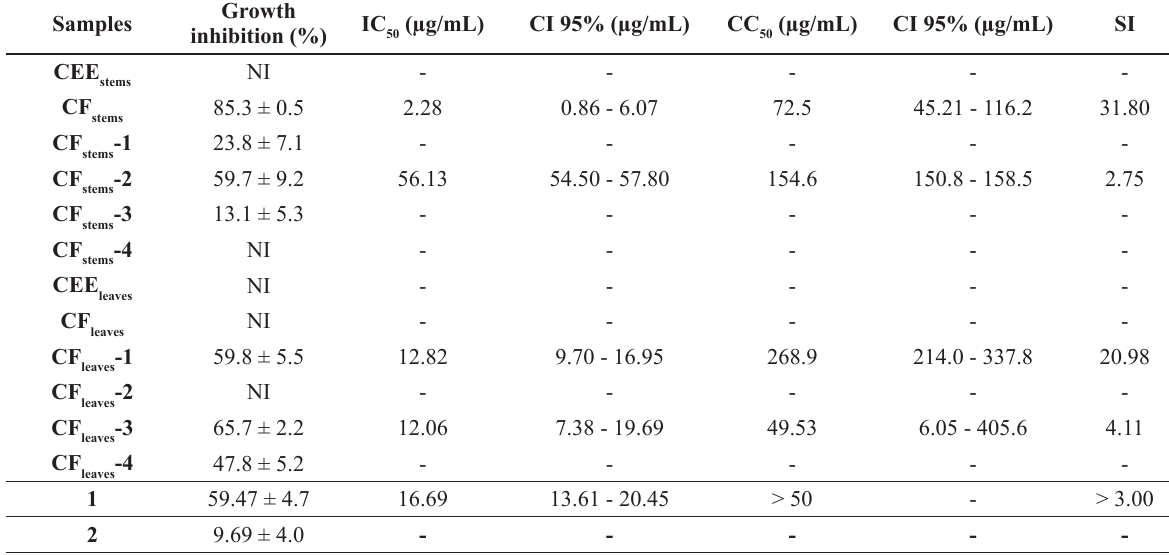
Antileishmanial screening (50 µg/mL) against Leishmania amazonensis